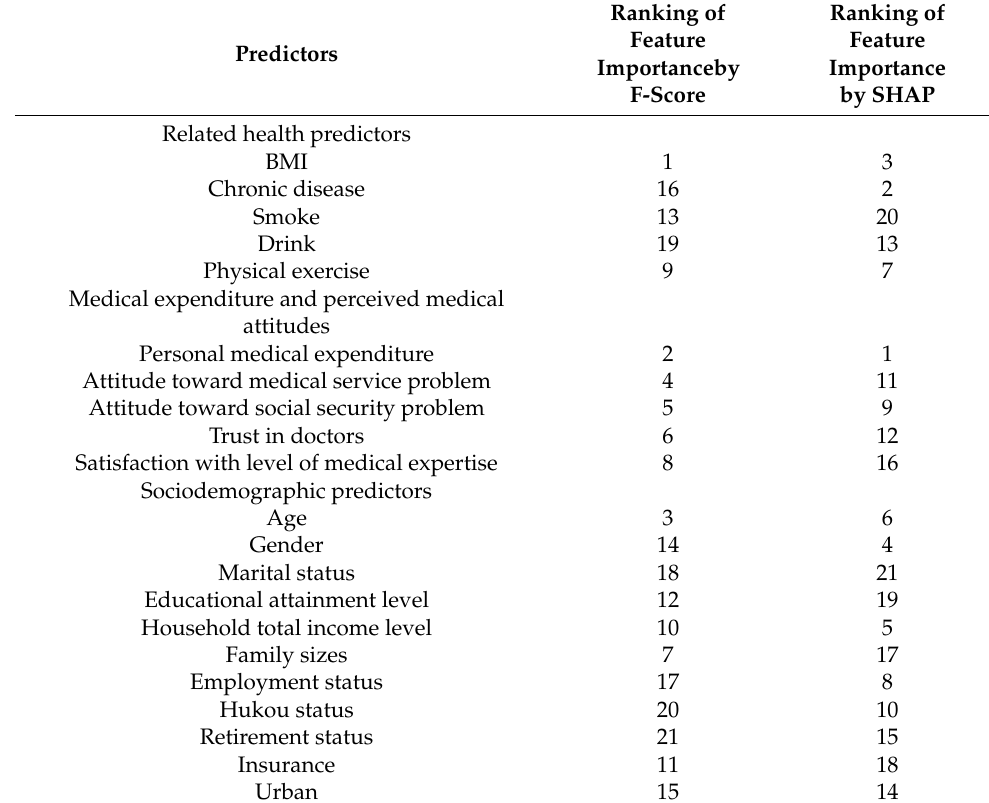
Ranking of Feature Importance by SHAP